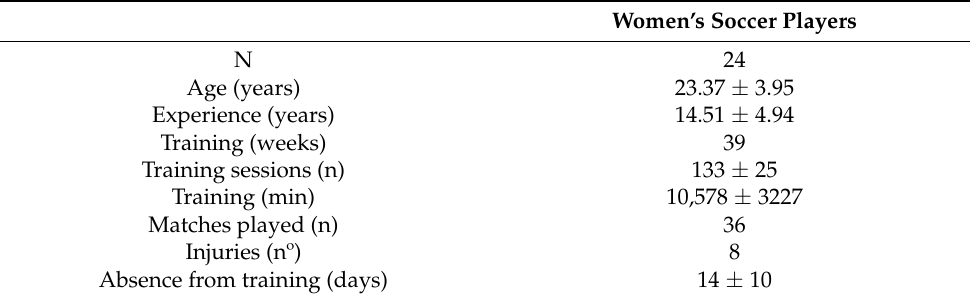
Table 1. Participants and training